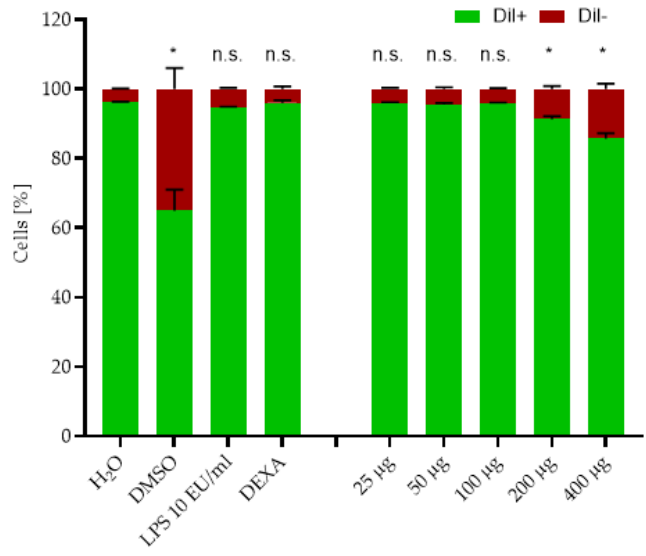
Figure A5. Effects of SPION HAp on the viability of Jurkat cells (ACC 282). Cells were incubated with SPION HAp particle concentrations of 25 to 400 µg/mL. After 48 h, cells were stained with Annexin A5 FITC conjugate (AxV) and propidium iodide (PI) to detect apoptotic and necrotic cells by flow cytometry. Viable cells (AxV- PI-) are visualized in green, apoptotic cells (AxV+ PI-) in blue, and necrotic cells (PI+) in red. The experiments were performed in triplicate. The mean values are shown with SD. Significance between treatment groups and control (viable cells) at the respective time is indicated by asterisks: * p < 0.05. p values higher than 0.05 were assumed to be not significant (n.s.).